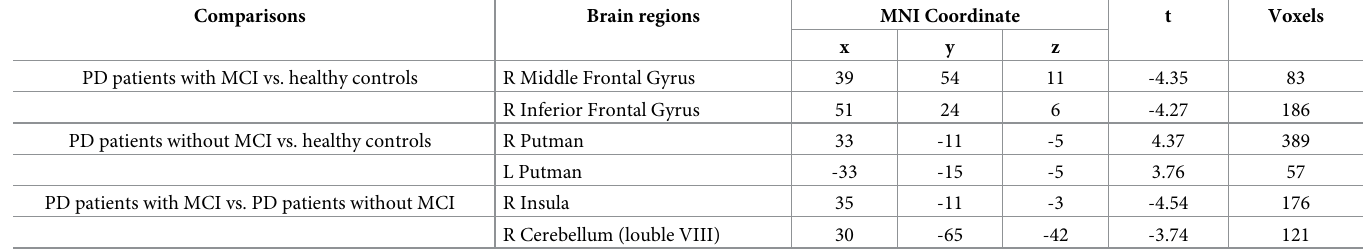
Table 2. Differences of GMV between the groups by VBM analysis. Comparisons PD patients with MCI vs. healthy controls PD patients without MCI vs. healthy controls PD patients with MCI vs. PD patients without